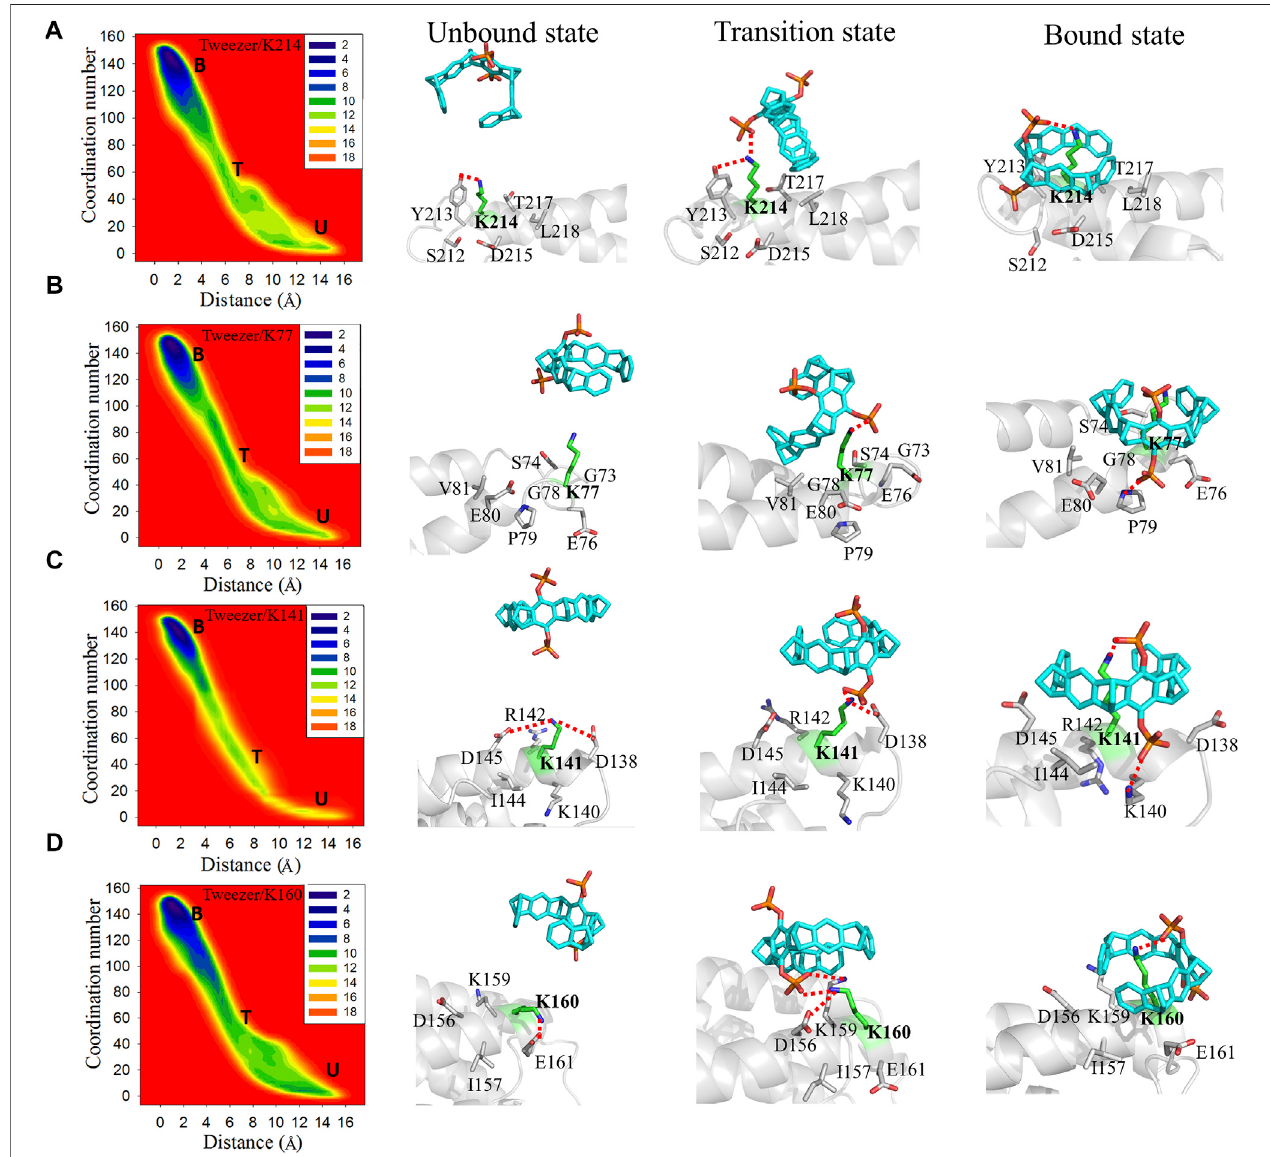
FIGURE3| Two-dimensionalfreeenergylandscapesandrepresentativestructuresforthebindingofthetweezerto (A) K214, (B) K77, (C) K141,and (D) K160on 14-3-3 σ . The symbols “ U, ” “ T, ” and “ B ” in the free energy landscapes indicate the unbound, transition, and bound states, respectively. The representative structures of the unbound states, transition states, and bound states of these lysine residues to the tweezer are shown on the right side of the free energy landscapes. The superimposed structures of the three states for each binding site are depicted in Supplementary Figure S9 .